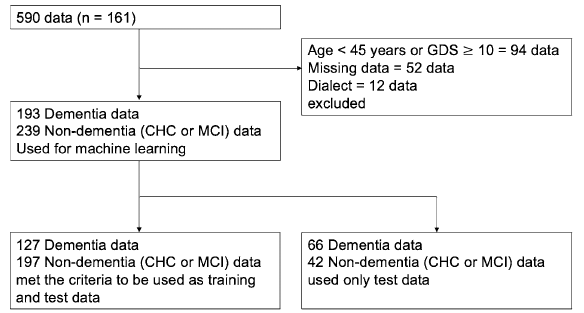
Figure 1. Number of datasets used for training and testing. GDS: Geriatric Depression Scale. CHC: cognitively healthy control. MCI: mild cognitive impairment.